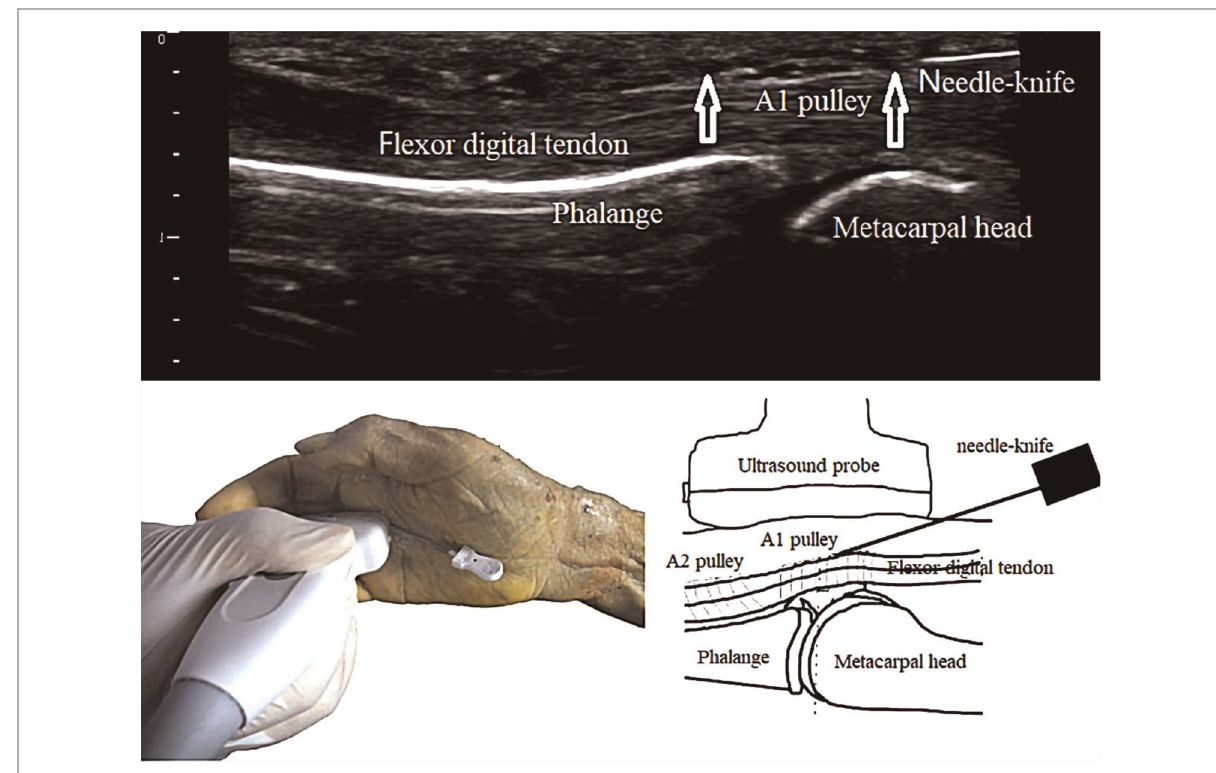
FIGURE 2 ultrasound-guided percutaneous A1 pulley release by